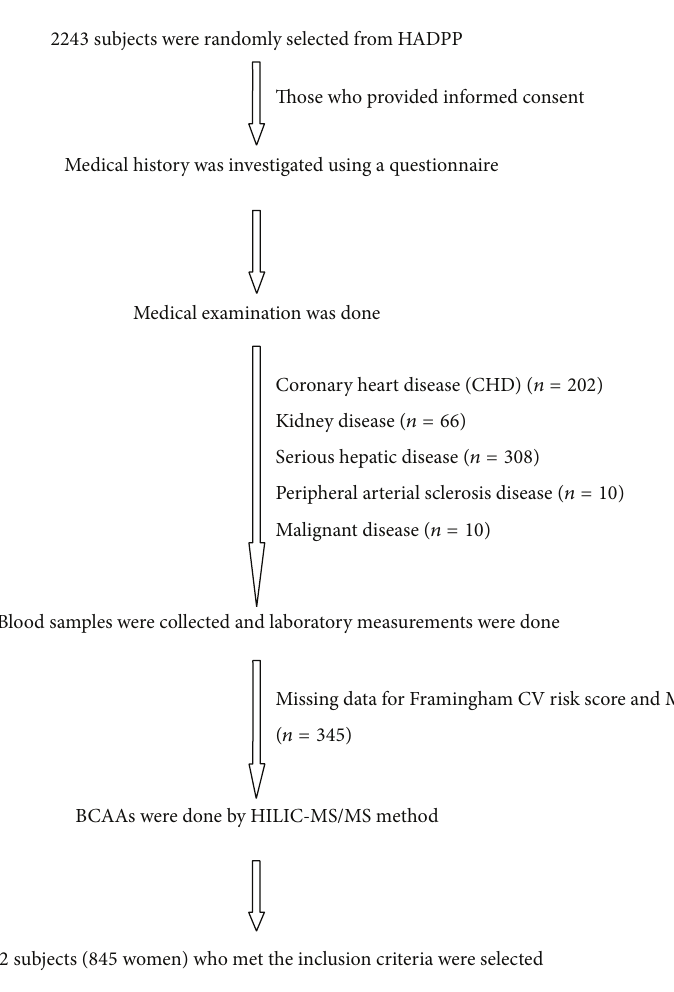
Figure 1: Subjects selection